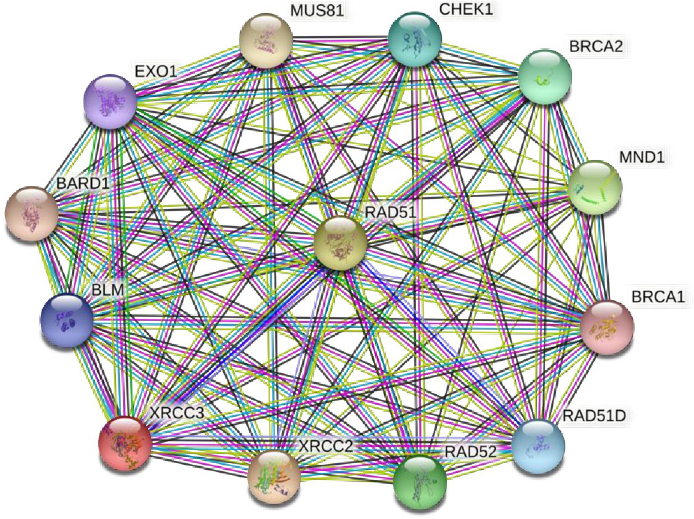
Fig 2. Protein-protein interaction. STRING software depicts the protein-protein interaction network of XRCC2, XRCC3 and RAD51. The first ten proteins that primarily interacts with XRCC2, XRCC3 and RAD51 is highlighted.